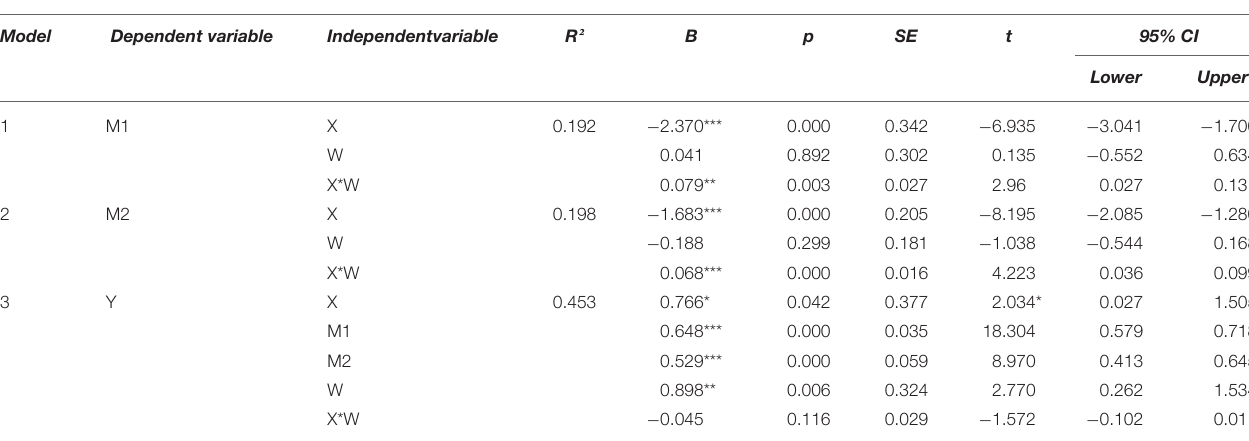
TABLE 3 | Model for the moderated-mediation hypothesis.